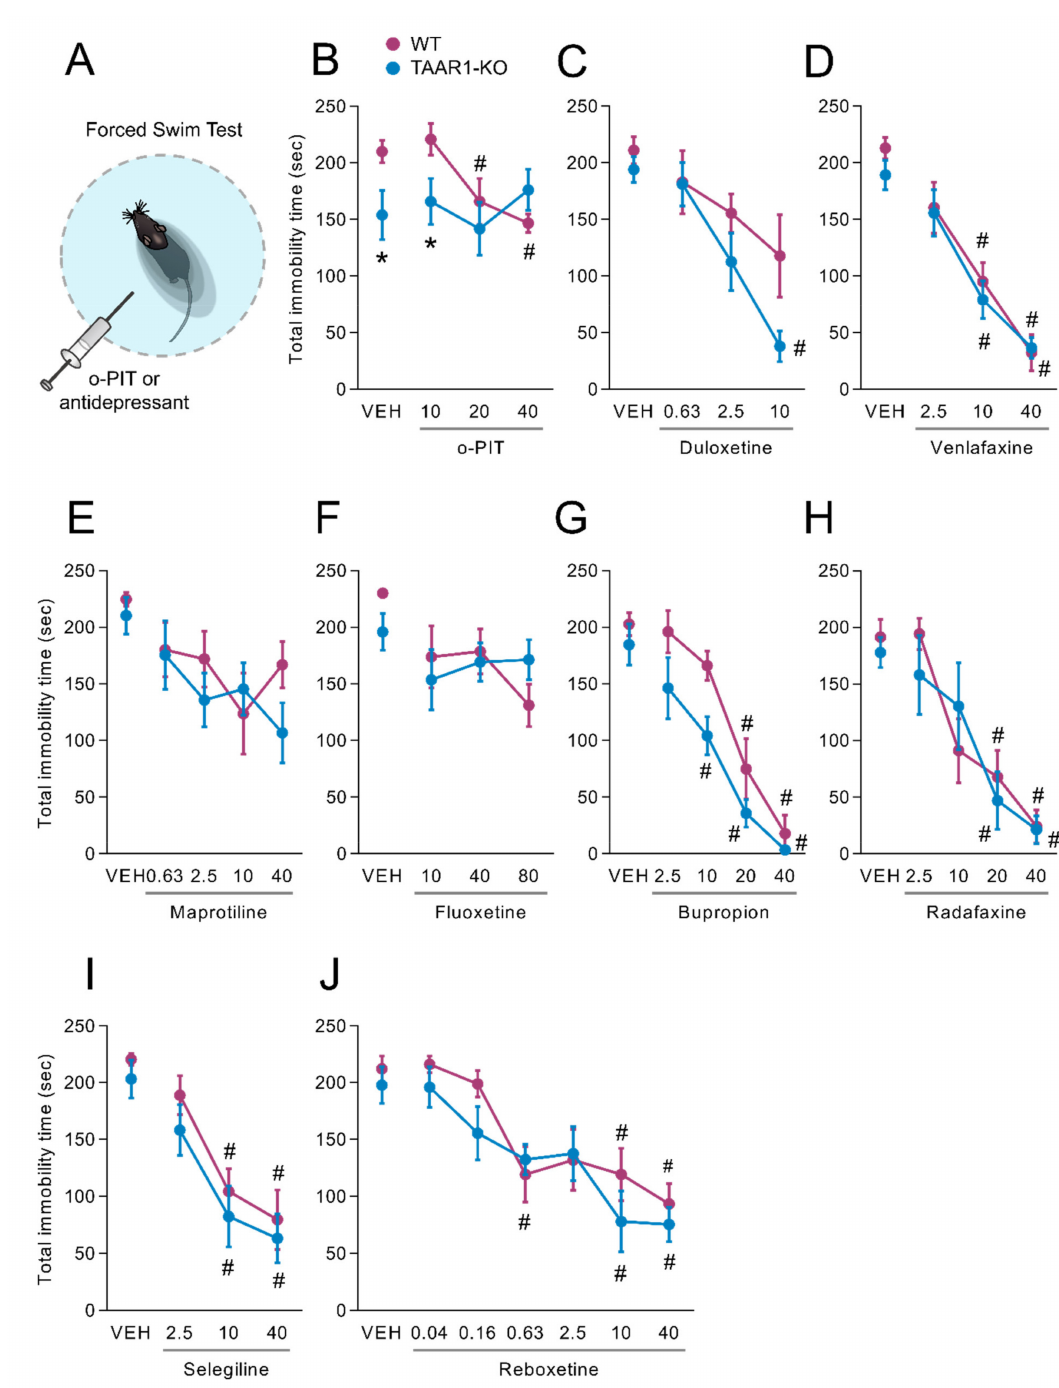
Figure 7. Influence of o-PIT on forced-swim test in TAAR1-KO and WT mice. ( A ) Schematic depiction of forced- swim test. ( B – J ) Values correspond to the duration of immobility during 4 min test after acute o-PIT treatment (2.5–40 mg/kg) ( B ), duloxetine (0.63–10 mg/kg) ( C ), venlafaxine (2.5–40 mg/kg) ( D ), maprotiline (0.63–40 mg/kg) ( E ), fluoxetine (10–80 mg/kg) ( F ), bupropion (2.5–40 mg/kg) ( G ), radafaxine (2.5–40 mg/kg) ( H ), selegiline (2.5–40 mg/kg) ( I ) and reboxetine (0.04–40 mg/kg) ( J ). Data represent means ± SEM. N = 8–12 per group. p < 0.05, influence of treatment (#) or genotype (*). VEH: